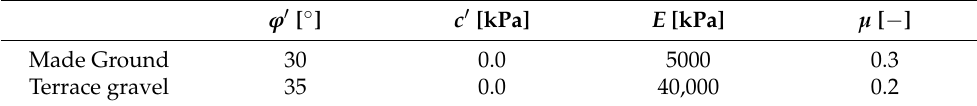
Table 5. Input parameters for Mohr–Coulomb model for made ground and terrace